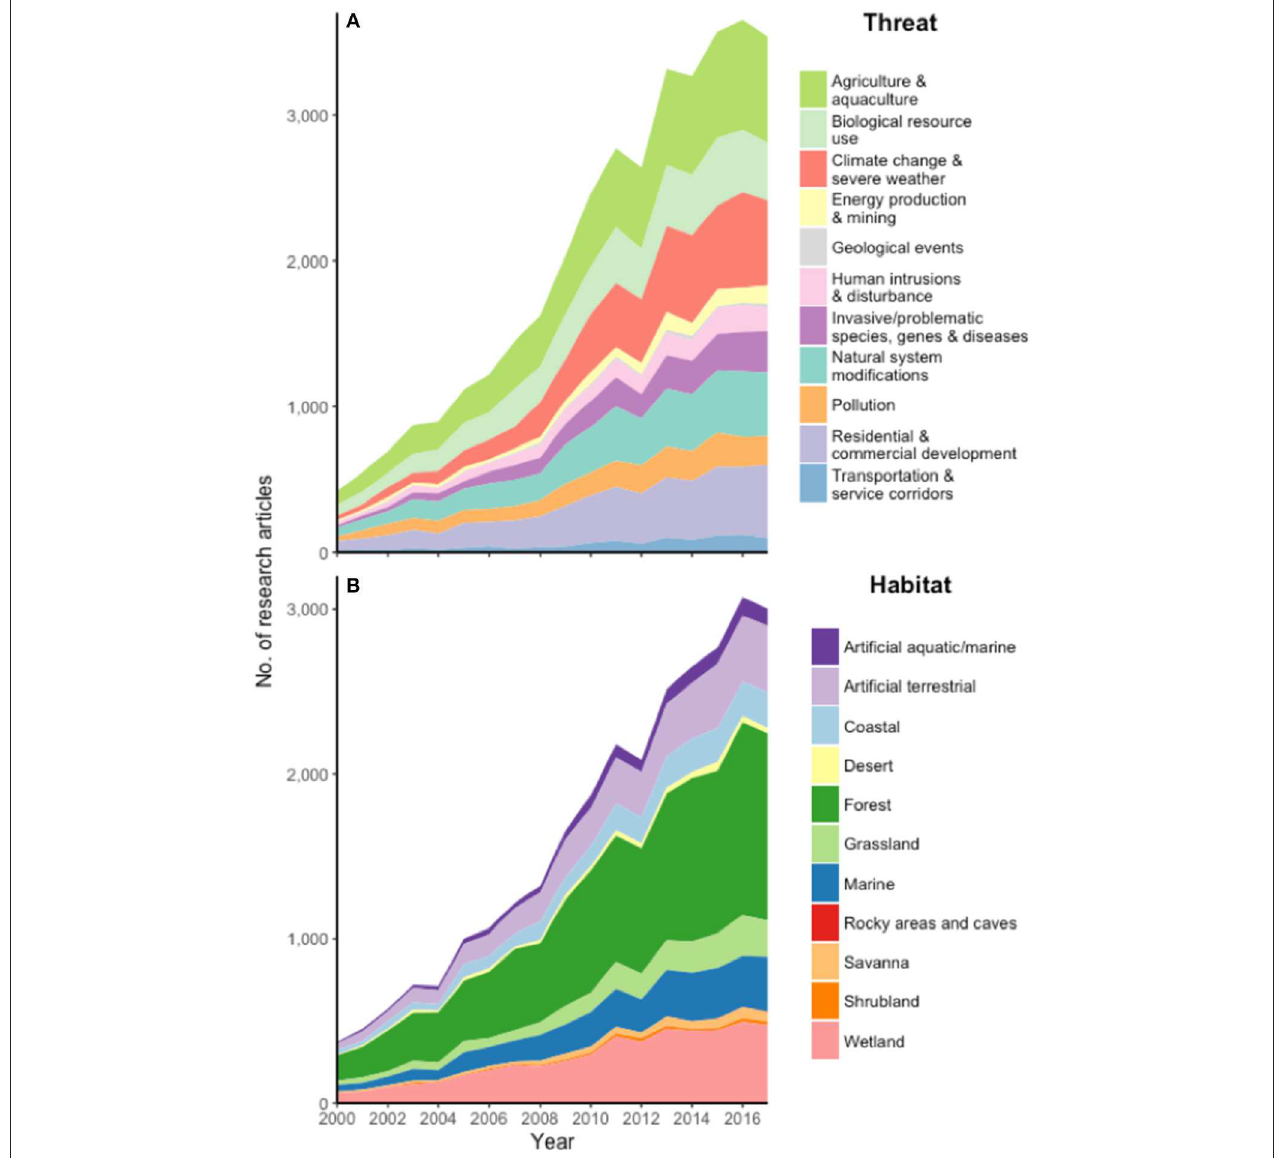
FIGURE 2 | The number of research articles relating to Red List Threats and Habitats. Research articles allocated to a specific Threat (A) or Habitat (B) contained “biodiversity” and “conservation” and at least one keyword corresponding to the Threat or Habitat, in the title, keywords, or abstract of the article. Data are for 01/01/2000 to 31/12/2017 and obtained from Scopus literature database (Elsevier,